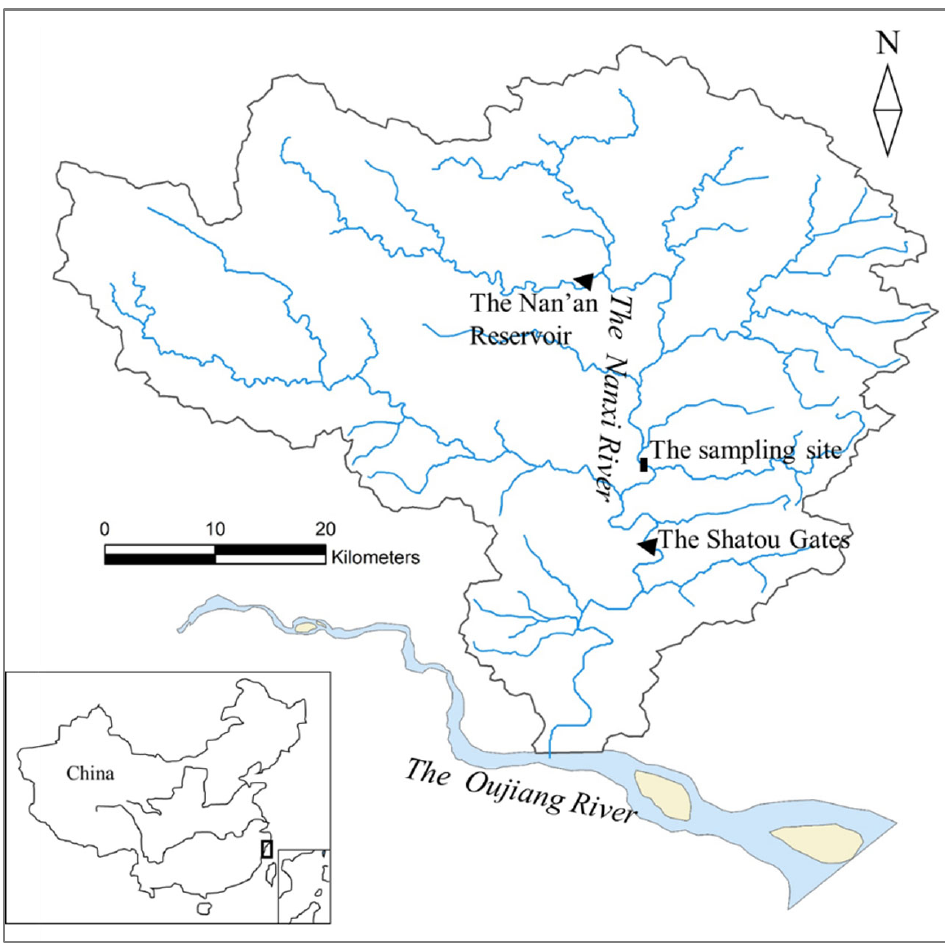
Figure 1. The Nanxi River and the sampling site of cobbles for tests.